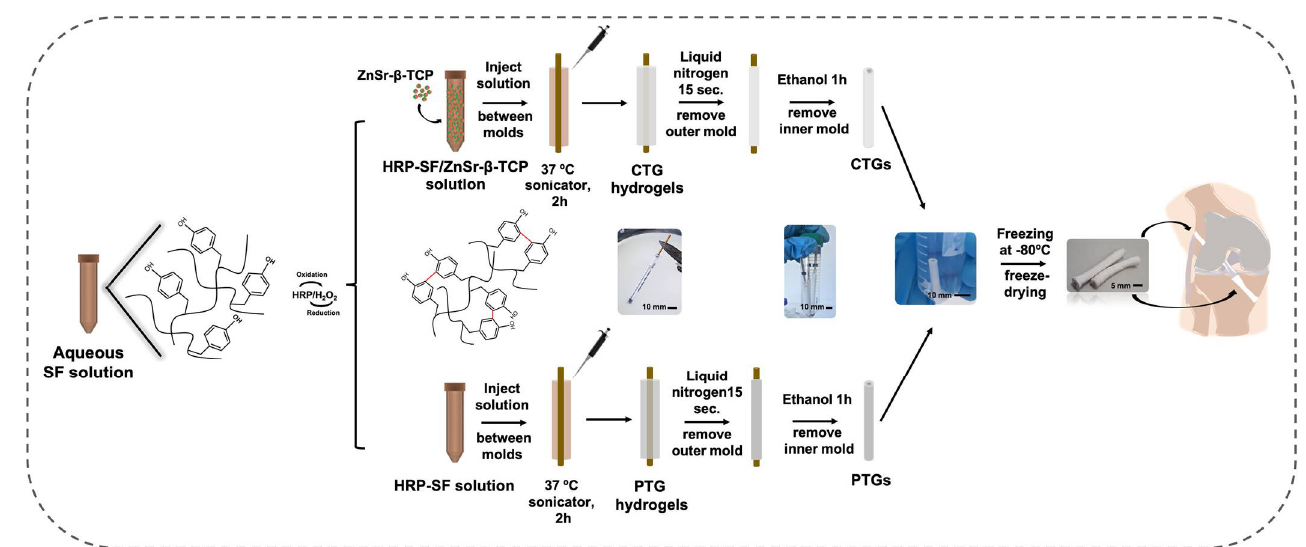
Figure 1. Schematic of the experimental setup used for preparing the CTGs, by processing the HRP-SF solution combined with the ZnSr- β -TCP powders in an 80/20 ( w / w ) ratio inside cylinder molds. HRP-SF solution processed alone was used to produce the PTGs used as control. Illustration shows the ultimate application of the CTGs as bone tunnel fillers in ACLGs implantation strategies.